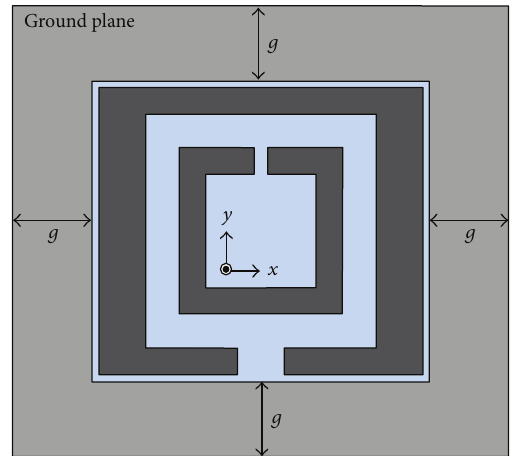
Figure 11: Direction of extension parameter 𝑔